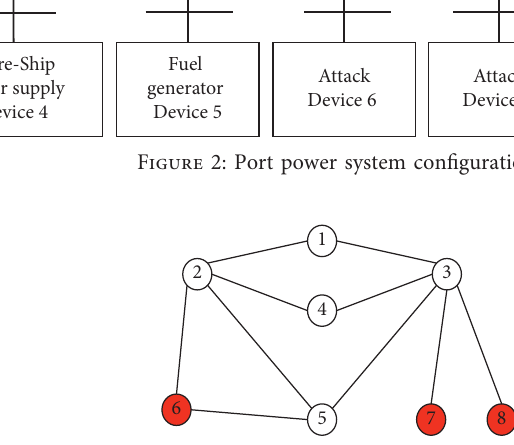
Figure 3: Network topology under FDIAs.